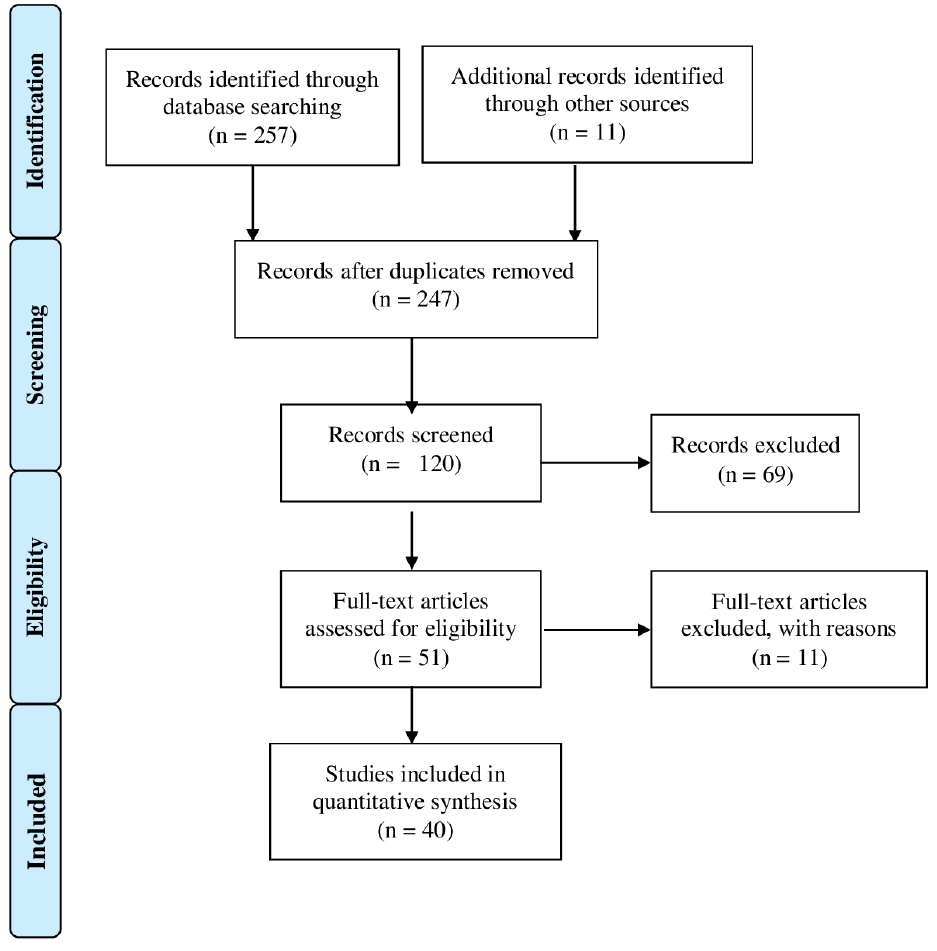
Figure 2. Prisma 2009 flow diagram of the included studies.